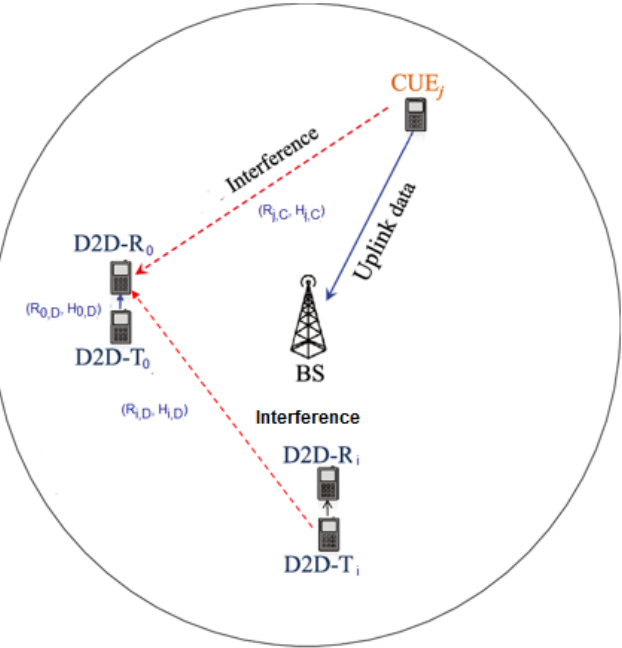
Figure 2. System